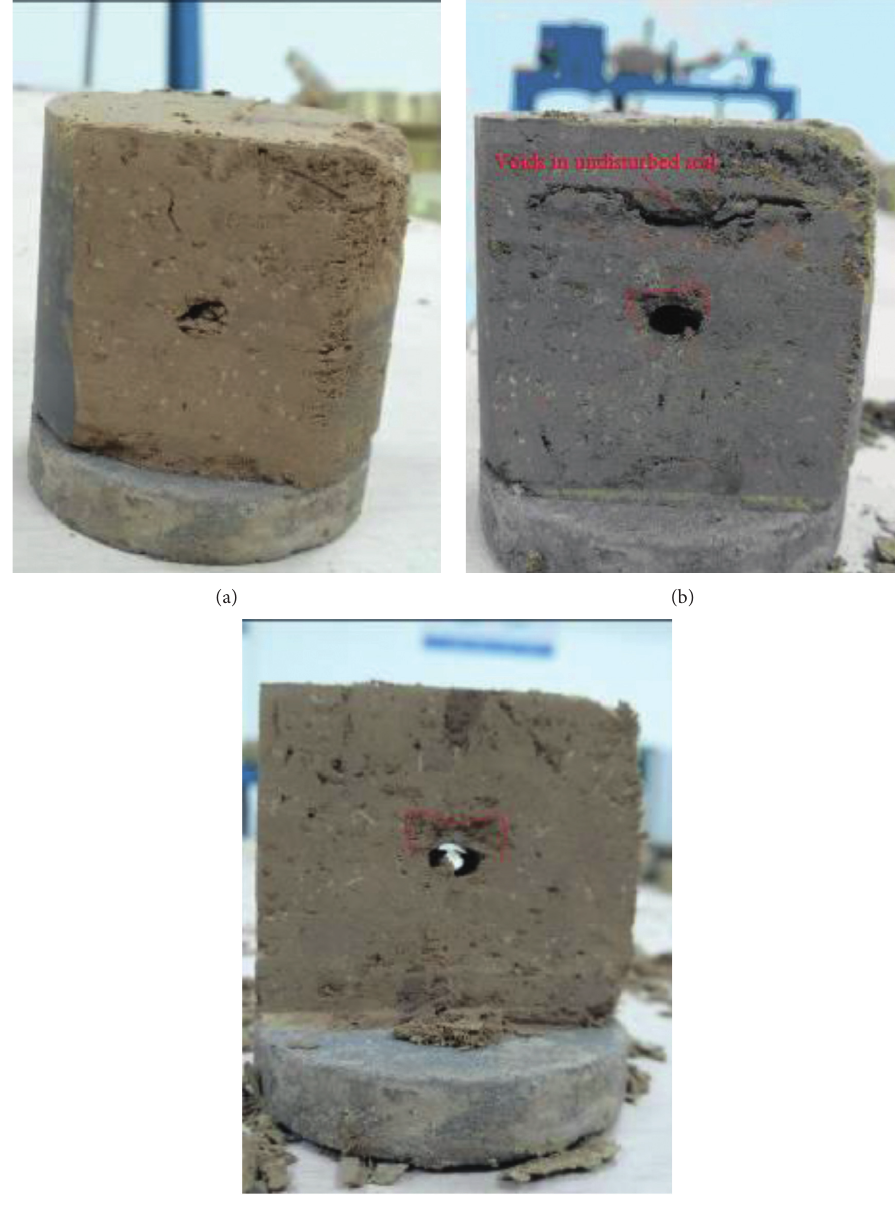
Figure 6: Failure mode of the slice perpendicular to the drilling direction: (a) failure mode of the drilling hole at the 1/4 radius section, (b) failure mode of the drilling hole at the 1/2 radius section, and (c) failure mode of the drilling hole at the diameter